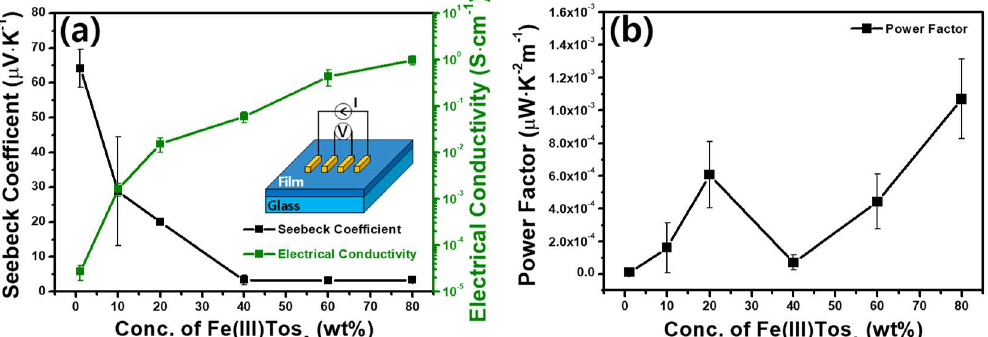
Figure 7. ( a ) The electrical conductivities and the Seebeck coefficients of PEDOT-Tos with different catalyst concentrations are plotted (the error bars are based on the standard deviations of the measured data). ( b ) Power factor (S 2 · σ ) based on the measured data is also calculated with µ W · K -2 m -1 unit and plotted.